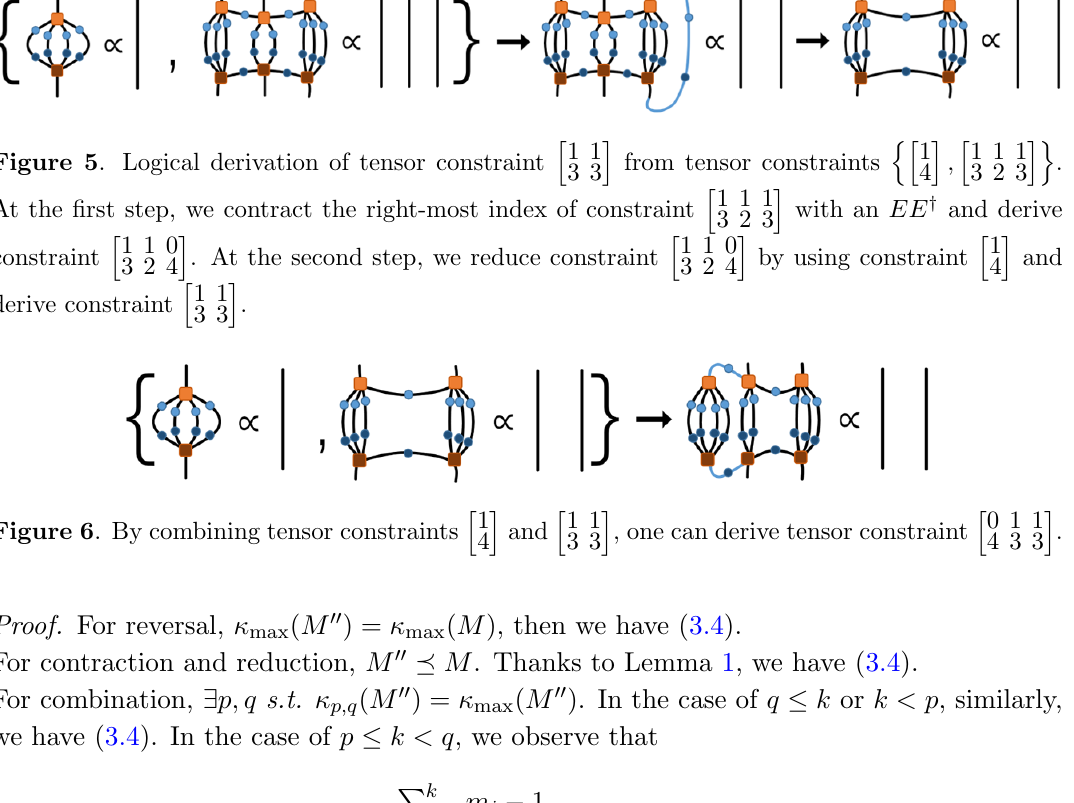
Figure 6 . By combining tensor constraints